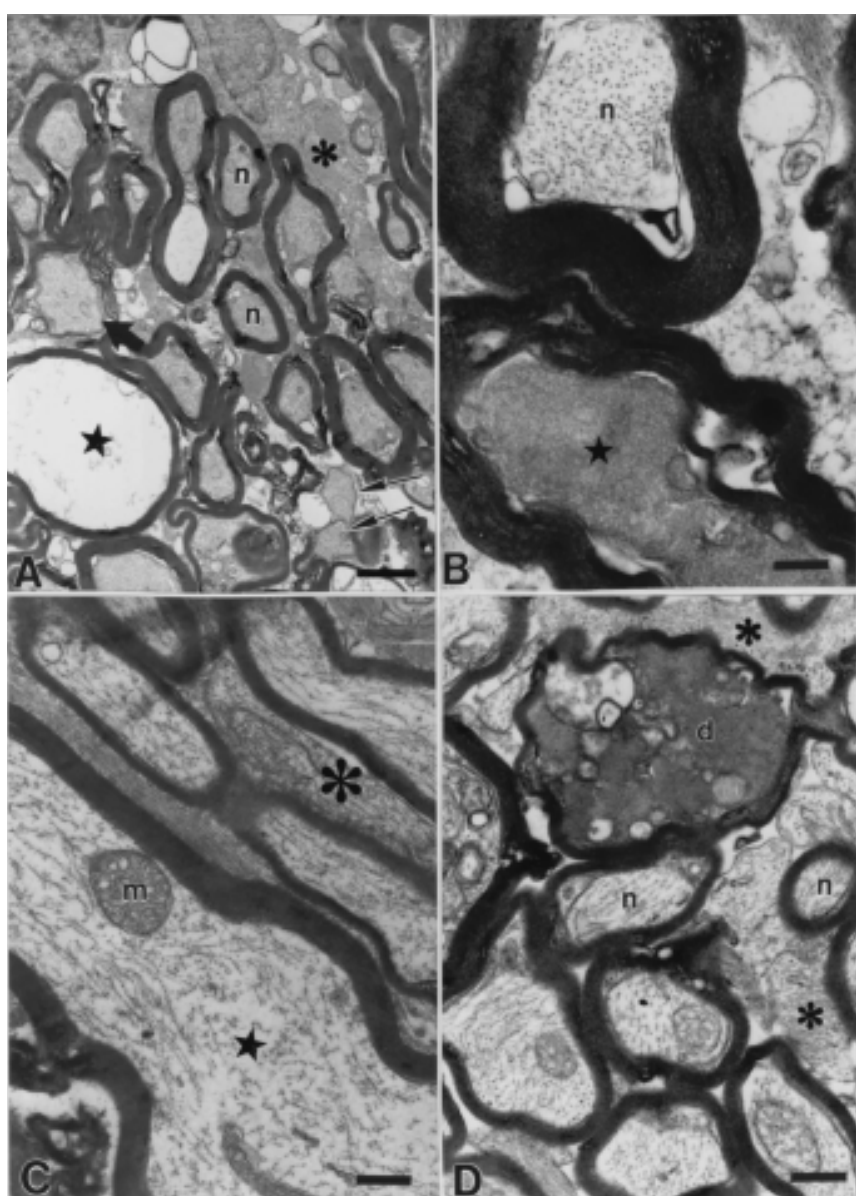
Fig. 1 – Ultrathin sections of opossum’s optic nerve fibers, 24 (A and B) and 48 hours (C and D) after crush. A. Normal fibers (n) are seen among some altered fibers, which exhibit watery degeneration (star) and myelin sheath breakdown (thick arrow). Note demyelinated fibers (thin arrows) with an apparently intact axoplasmic cytoskeleton. Asterisk, astrocytic processes. Bar = 1 . 7 µ m. B. Normal looking optic nerve fiber (n) is seen above an optic fiber showing dark degeneration (star). Bar = 0 . 4 µ m. C. Longitudinal section of optic nerve fibers showing areas of focal degeneration of the axoplasmic cytoskeleton (star). Asterisk, astrocytic processes; m, mitochondrial profile. Bar = 0 . 6 µ m. D. Observe optic nerve fibers with an apparently normal appearance (n). Among them, there is a fiber with dense axoplasm and some altered organelles, typical of dark degeneration (d). Asterisks, astrocytic processes. Bar = 0 . 6 µ